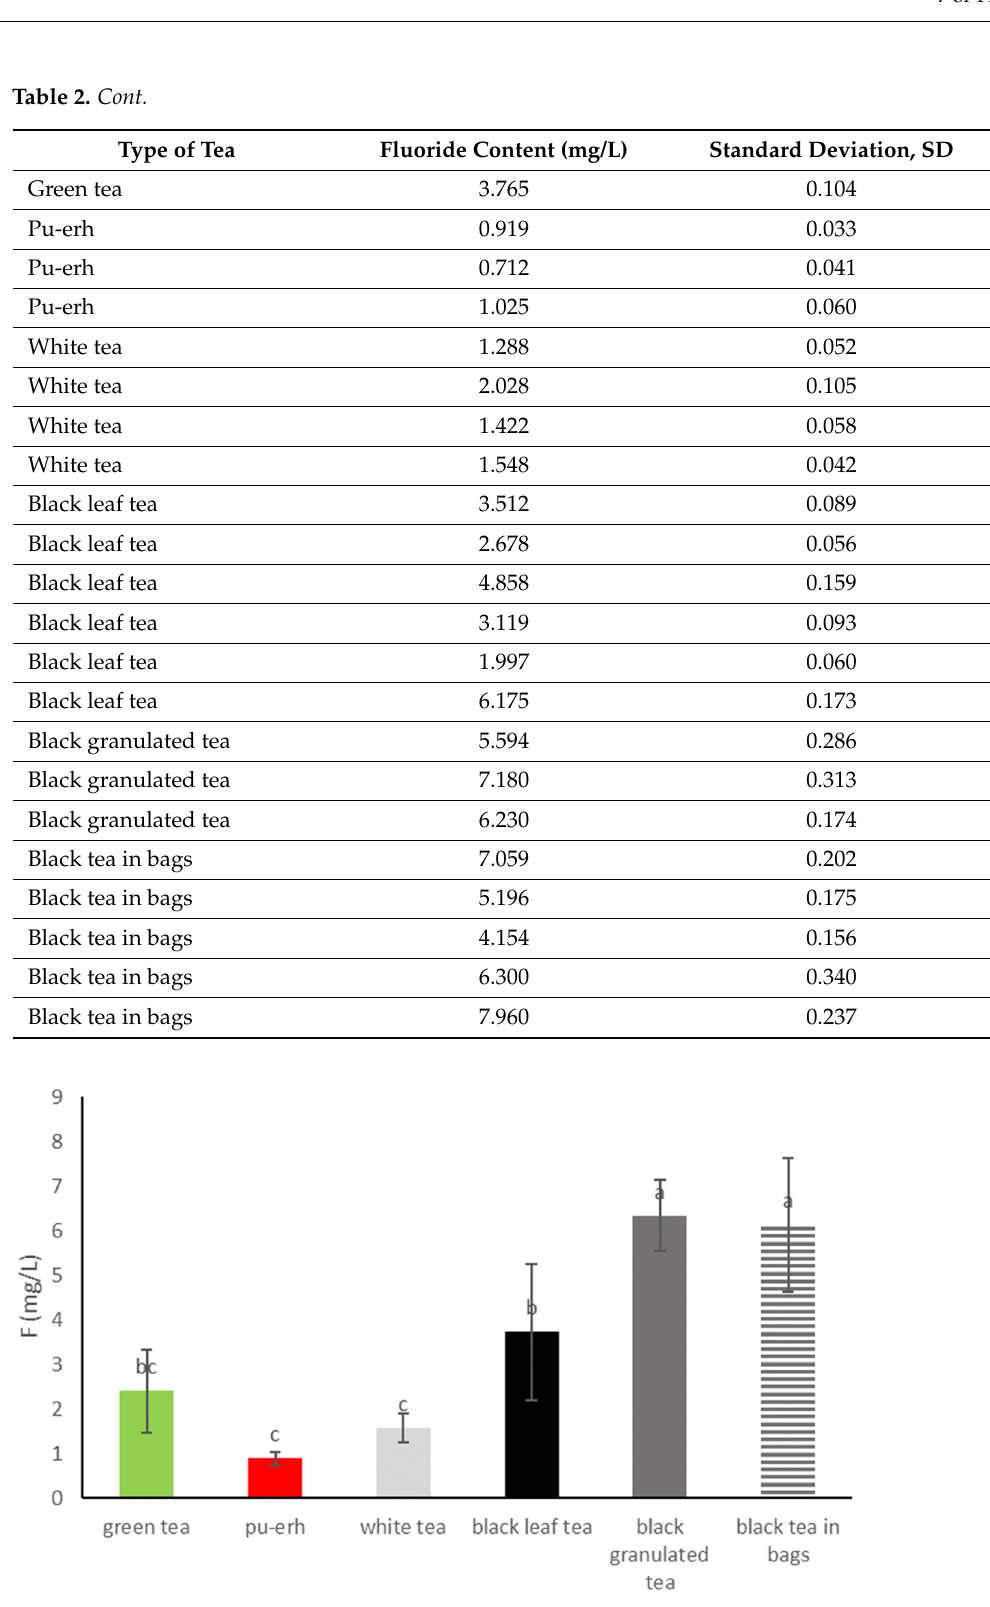
Figure 3. Mean and SD fluoride concentration (mg/L) in the tea groups. Different letters (a, b, c, etc.) show a significant difference with p < 0.05.